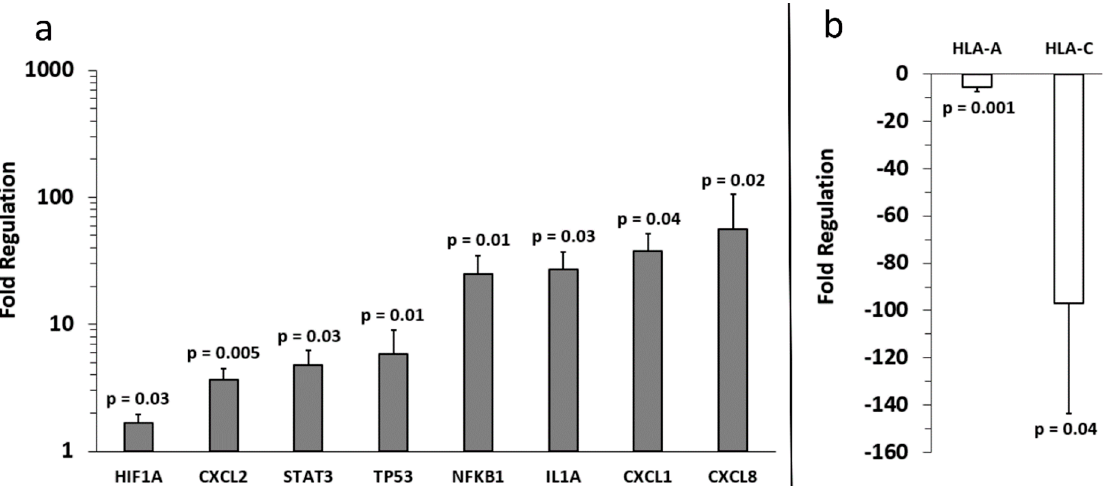
Figure 3. Fold regulation of A-375 melanoma sEV mRNA versus control primary melanocyte sEV mRNA. ( a ) Increased and ( b ) decreased gene expression levels relative to primary melanocytes (normalized to 1) are shown. Three independent sEV batches were pooled and run on ( n = 3) replicate arrays, error bars = SD, p values <0.05 were considered statistically significant.